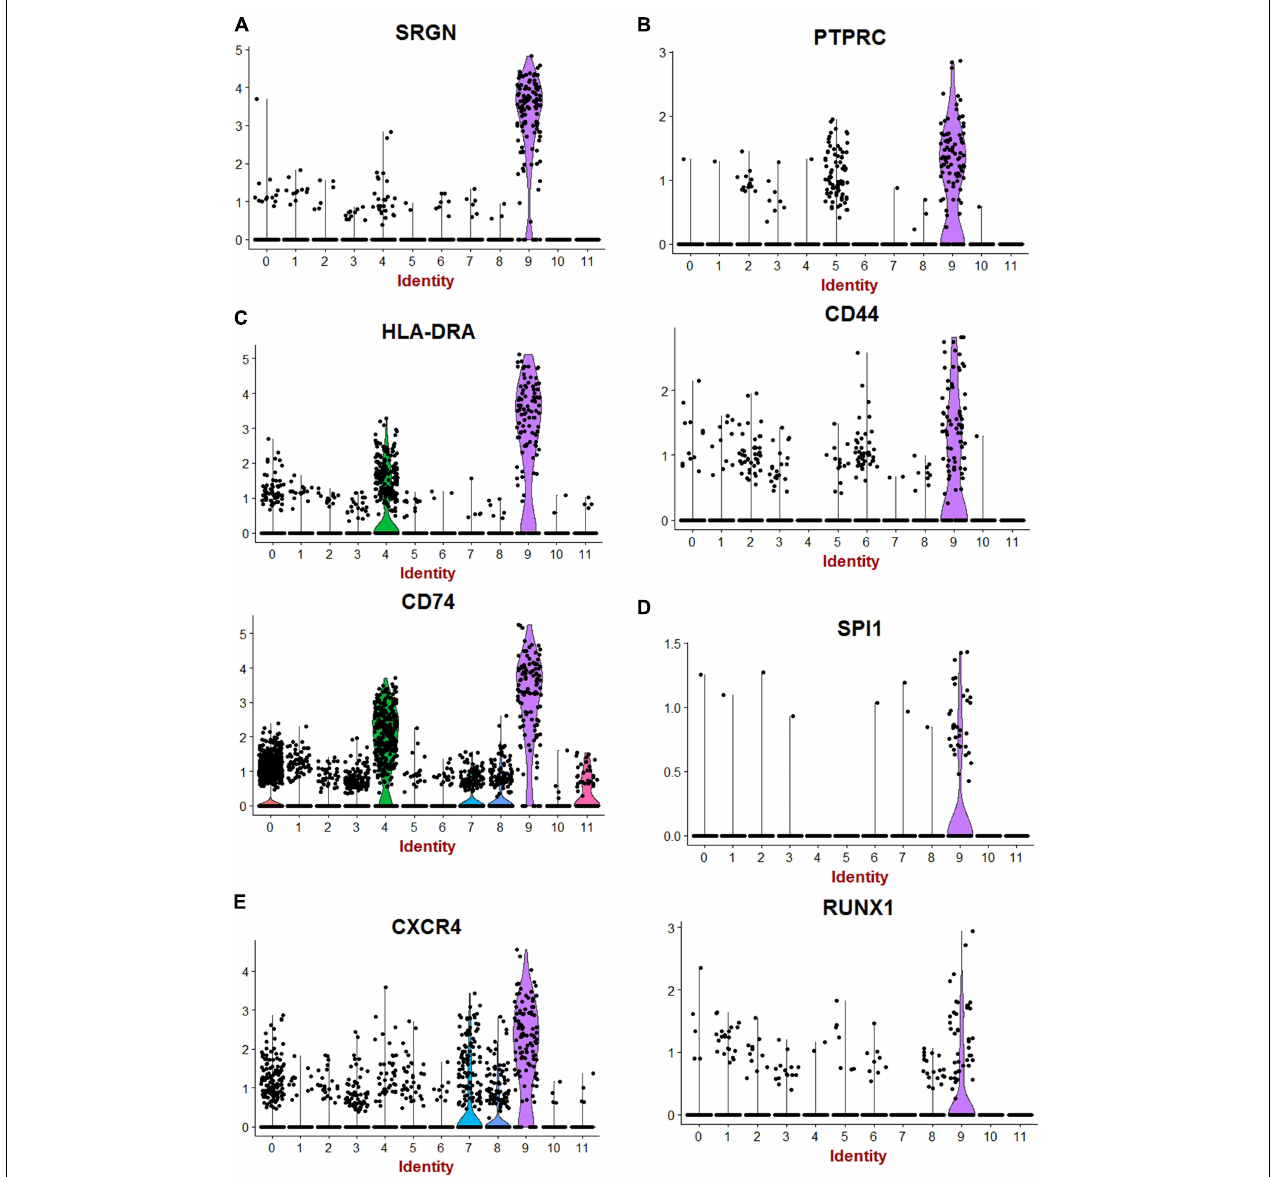
FIGURE 2 | Hematopoietic transcripts detected in human fetal kidney cortex by single-cell RNA sequencing. (A) Violin plot of serglycin (SRGN) expression. (B) Violin plot of hematopoietic clusters of differentiation (PTPRC Alias CD45). (C) Violin plot of expression of transcripts of differentiated hematopoietic cells (HLA-DRA:HLA-DR Alpha). (D) Violin plot of expression of SPI1 (PU.1) and RUNX1. (E) Violin plot of expression for CXCR4